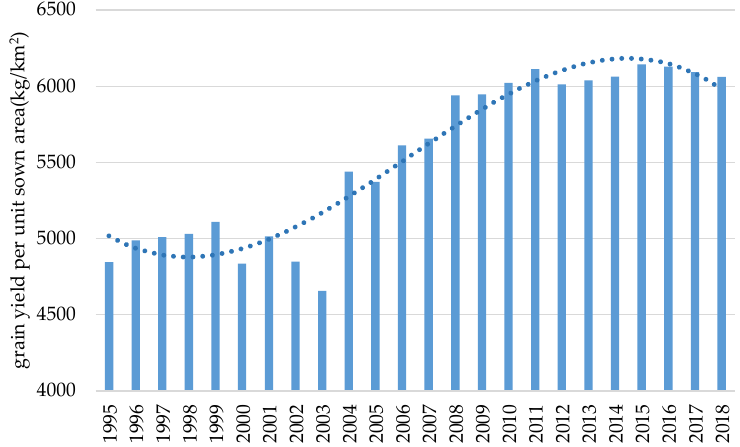
Figure 2. The temporal changes of grain production in the HHH from 1995 to 2018.